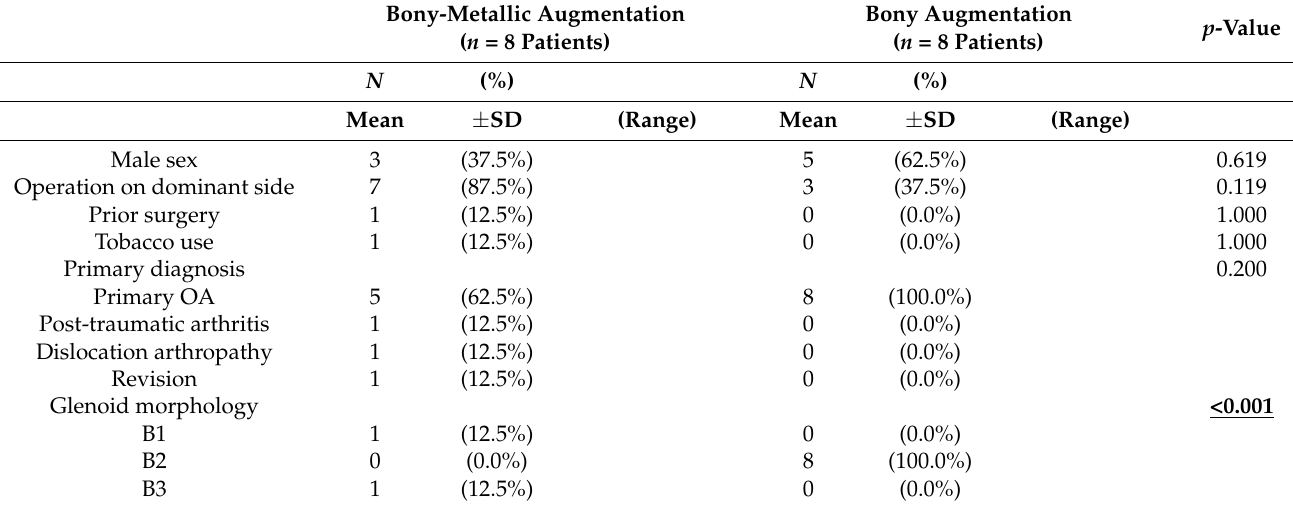
Table 1. Patient characteristics between the Bony-metallic augmentation (BMA) and Bony augmentation (BA) groups. Bony-Metallic